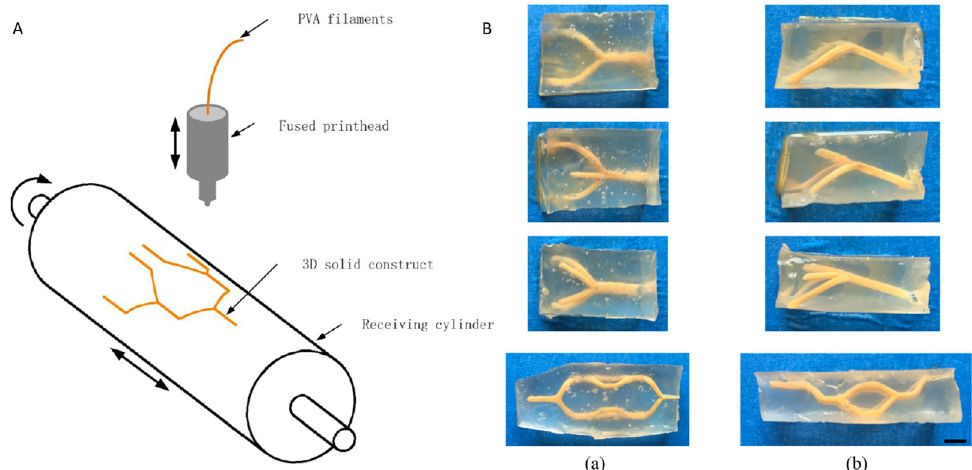
Figure 1. Schematic for the printing of the three-dimensional solid sacrificial template ( A ). ( B ) Perfusion of the fabricated connected networks. ( a ) Front view; ( b ) side view. Scale bar is 3 mm. Reprinted (adapted) with permission from [42]. Copyright © 2016, American Chemical Society.